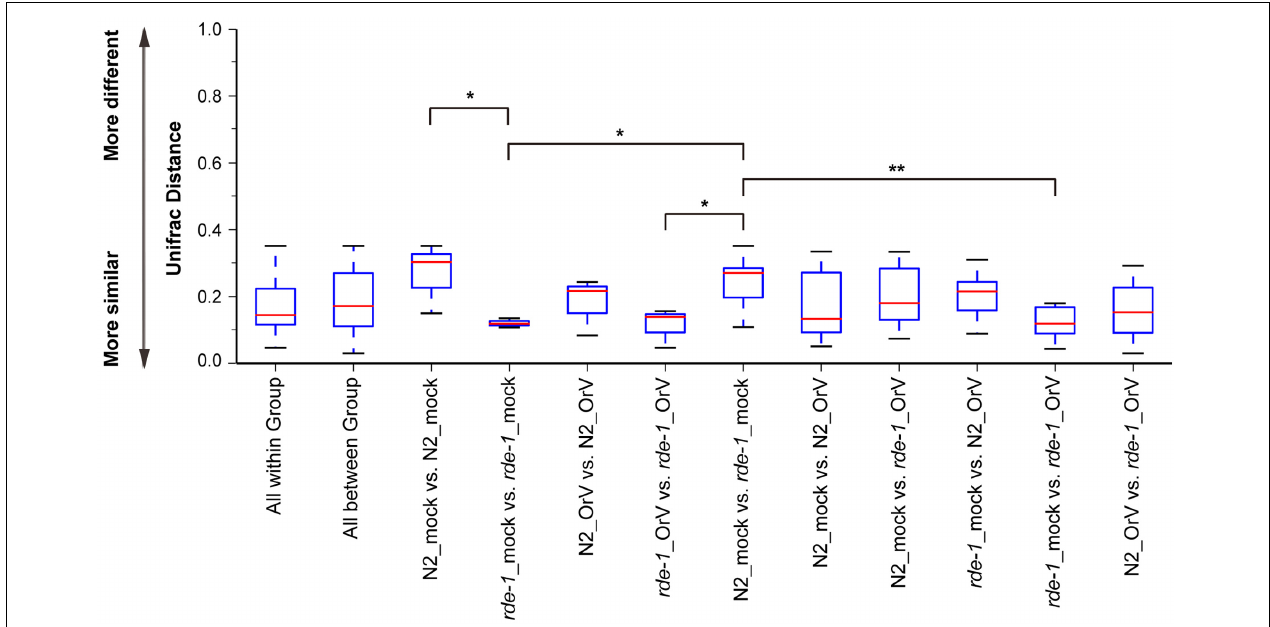
FIGURE 2 | Changes of the microbiota diversity due to Orsay infection. The average weighted UniFrac distance values (the beta diversities) of uninfected N2 (N2_mock), Orsay virus-infected N2 (N2_OrV), uninfected rde-1 ( ne219 ) mutants ( rde-1 _mock) and Orsay virus-infected rde-1 ( ne219 ) ( rde-1 _OrV). ∗ P < 0.05, ∗∗ P < 0.01 by one-tailed t